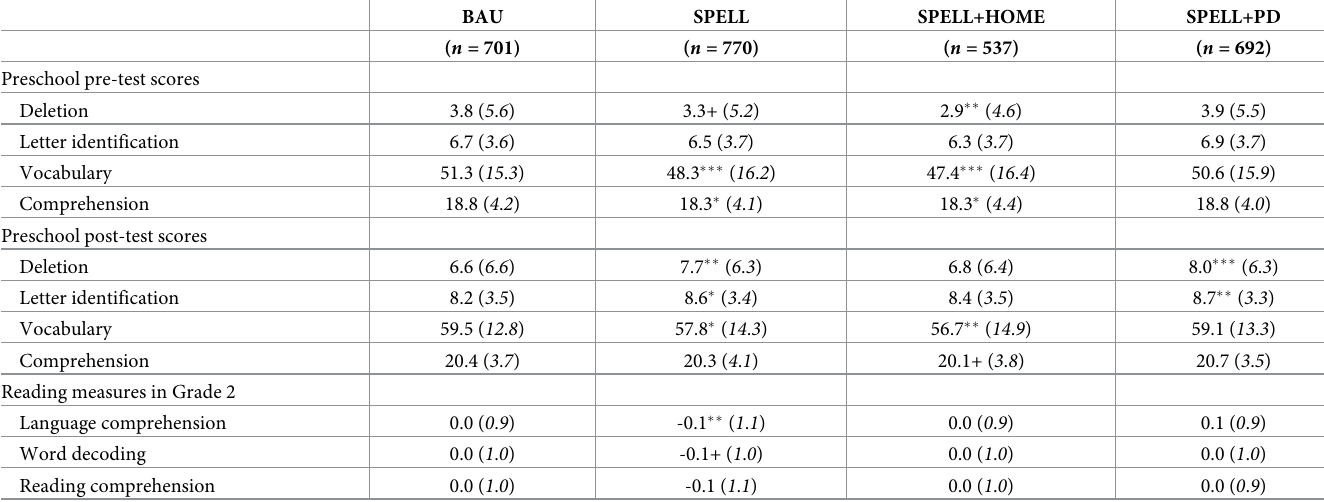
Table 3. Pre and post test scores from the original RCT study and the national test scores for children in the long-term study of SPELL.